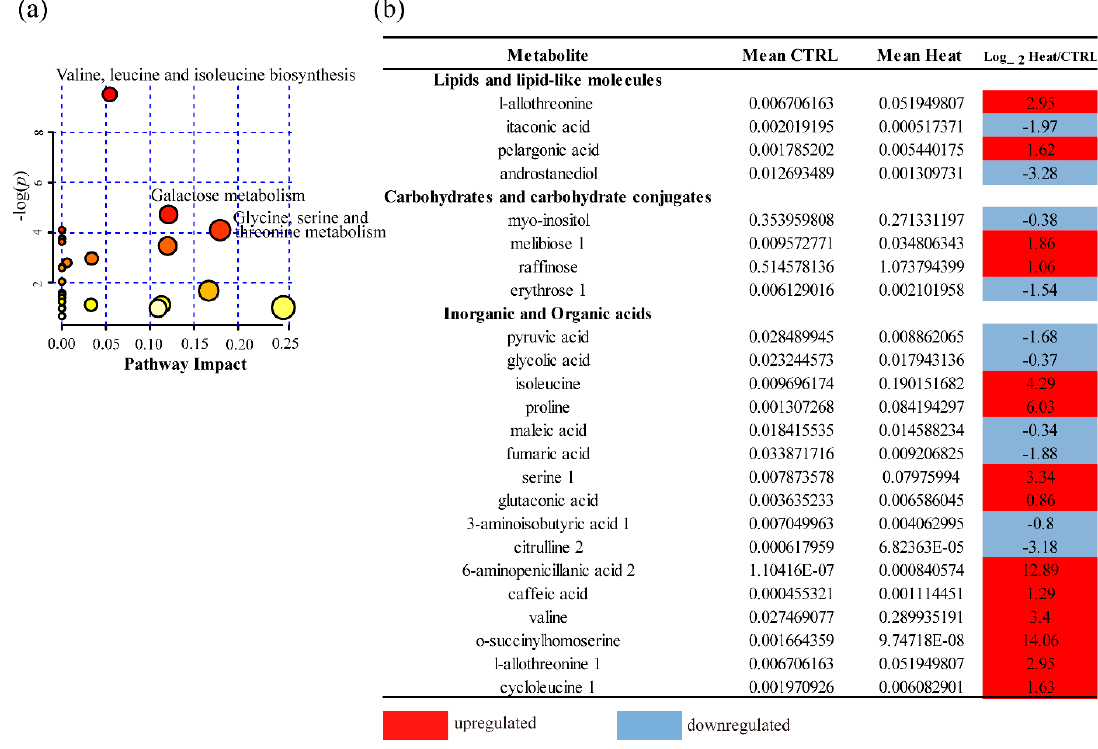
Figure 5. Metabolic changes in P. tomentosa under heat stress. ( a ) Map of enriched metabolic pathways; X-axis (pathway impact) and Y-axis [ − log( p )] show the topological analysis of impact factors and the p -value by pathway enrichment analysis, respectively. ( b ) Metabolites whose levels differed significantly between heat stress and the control.